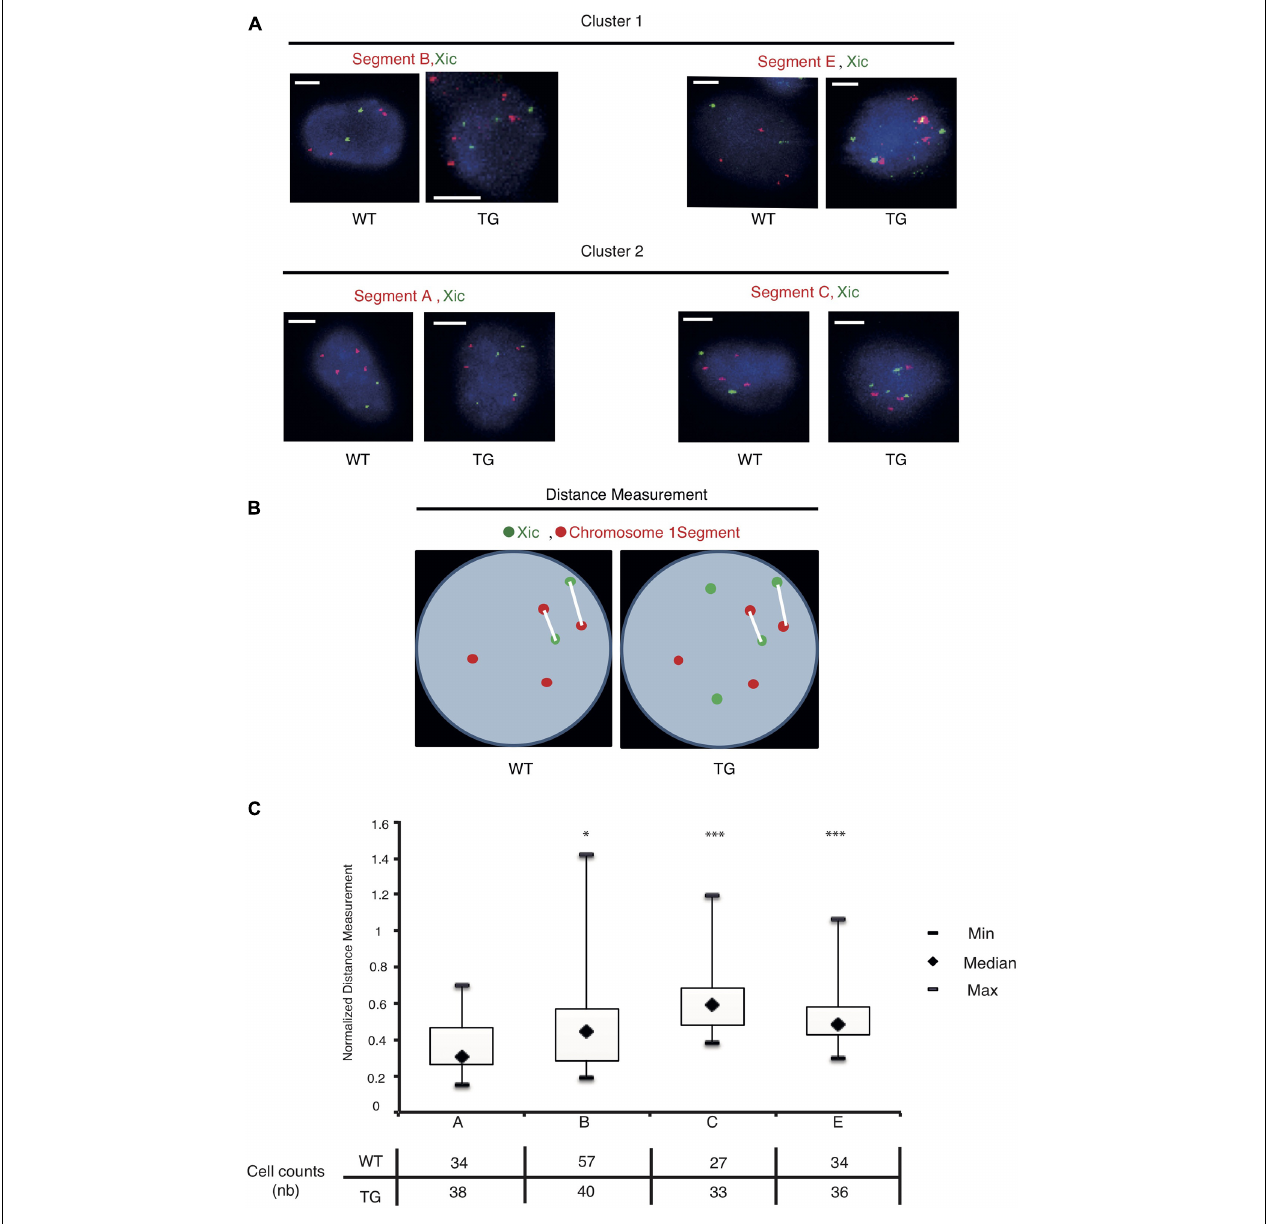
FIGURE 4 | The Xic transgene is in spatial proximity with the transcriptionally repressed sequence segments on chromosome 1. (A) Dual-color DNA FISH is performed using chromosome 1 segment probes in combination with Xic probes as indicated for WT and TG TTFs. Representative images are shown; the scale bar is 5 µ m in length. (B) Measurements of distance between the chromosome segment and Xic signals are illustrated with two shortest distances at display for each cell nucleus. (C) Boxplots of the normalized measurements for spatial distances between Xic and segments A, B, C, E, in TG cells. The table under the box plot shows the number of cells analyzed for each segment. ∗ p < 0.05, ∗∗∗ p < 0.001, by independent 2-group t -test as compared with Segment